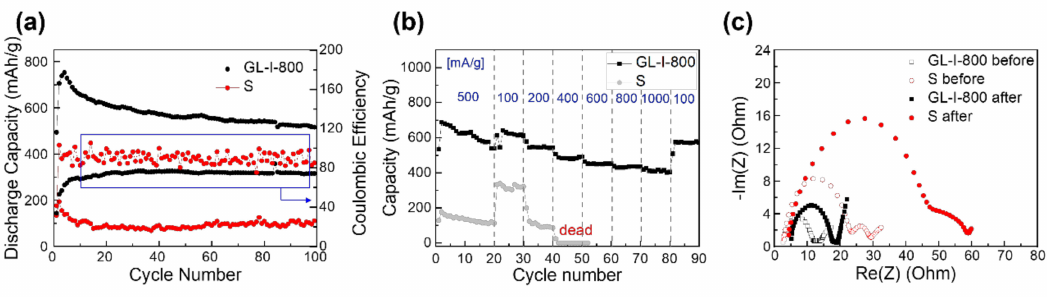
Figure 4. Electrochemical performance of Gl-I-800 + S and pristine S: ( a ) Discharge capacity vs. cycle number, ( b ) rate capability, and ( c ) electrochemical impedance spectroscopy (EIS) spectra.